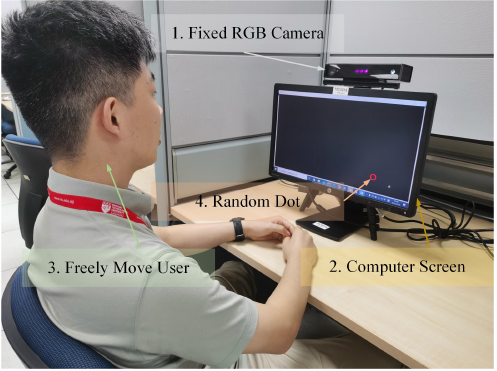
Figure 4. Used experimental platform.